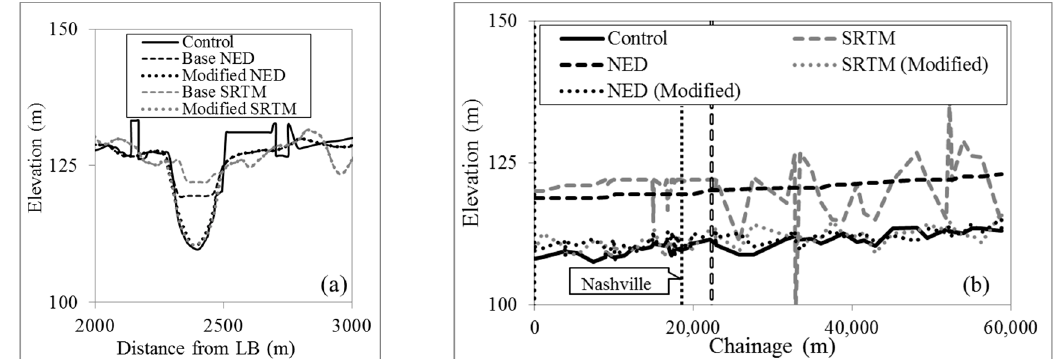
Figure 4. Comparison of ( a ) cross-sections at Nashville; ( b ) longitudinal channel profiles derived from control and test datasets.